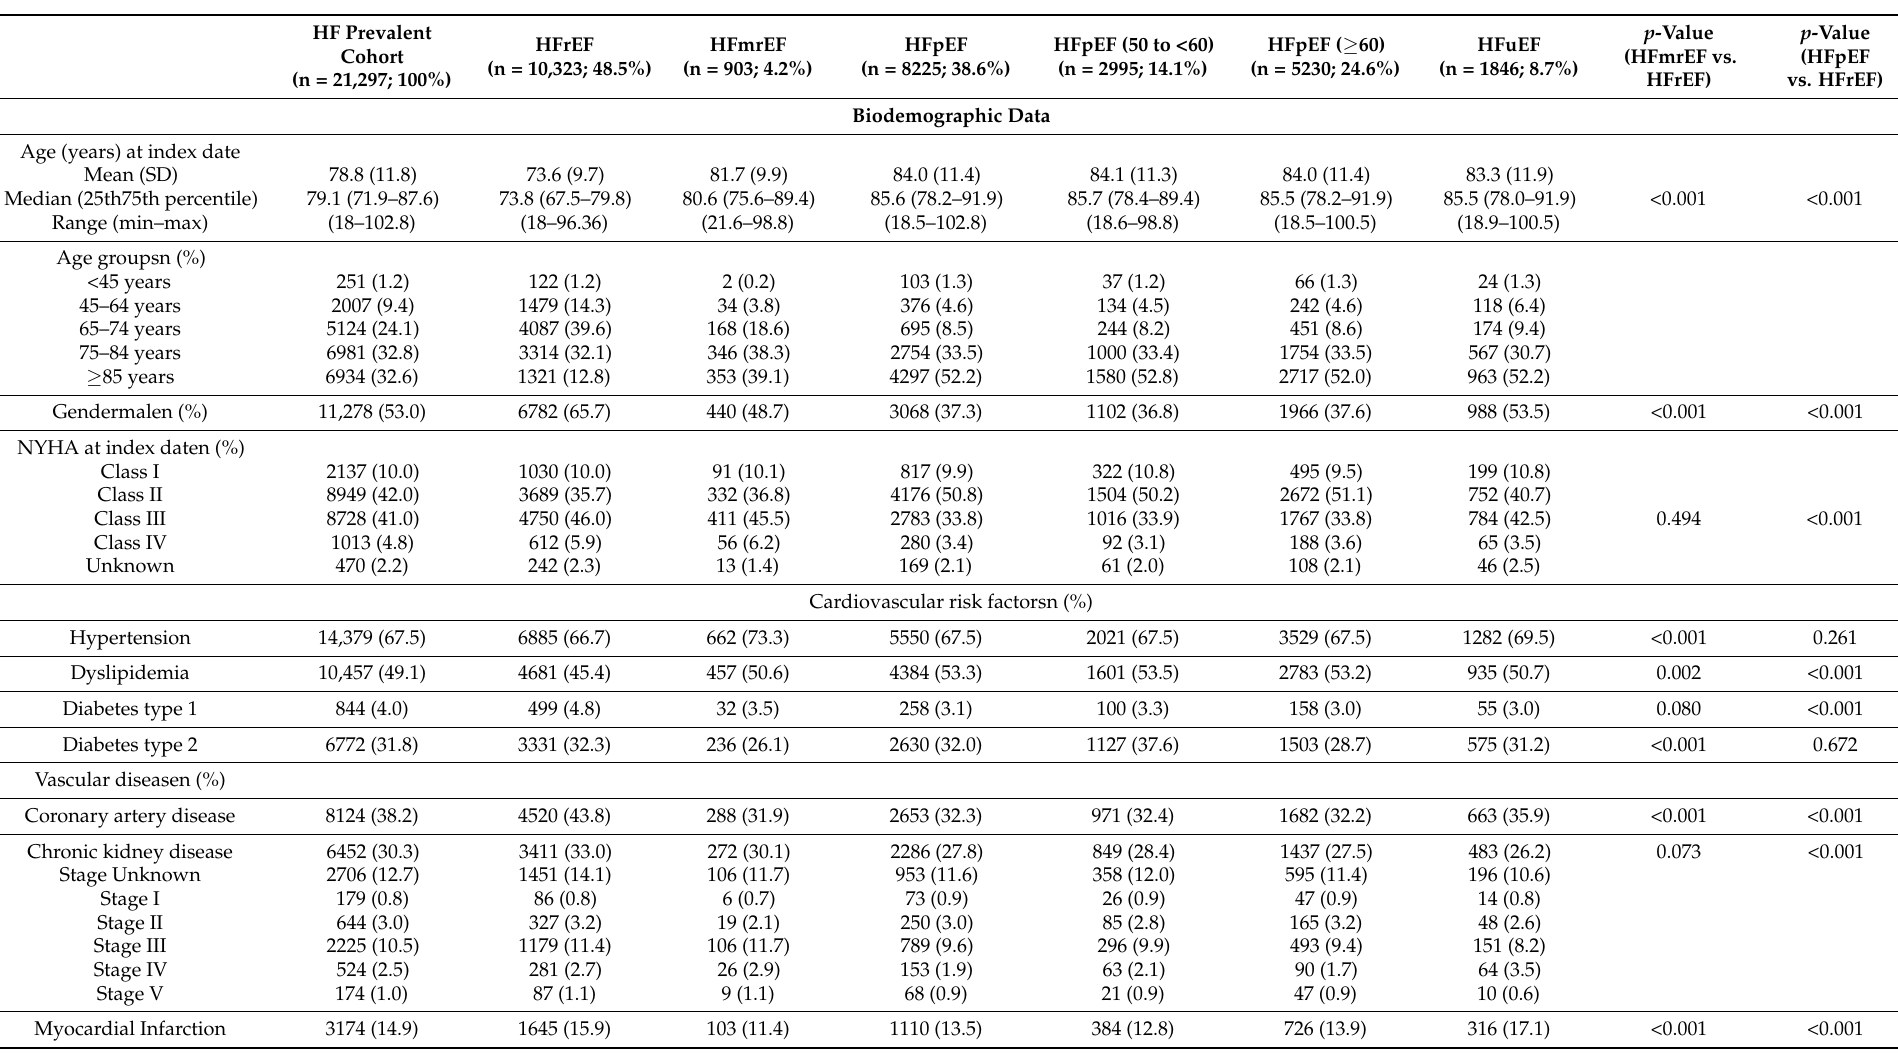
Table 1. Baseline characteristics and treatments in the prevalent heart failure cohort (index date 1 January